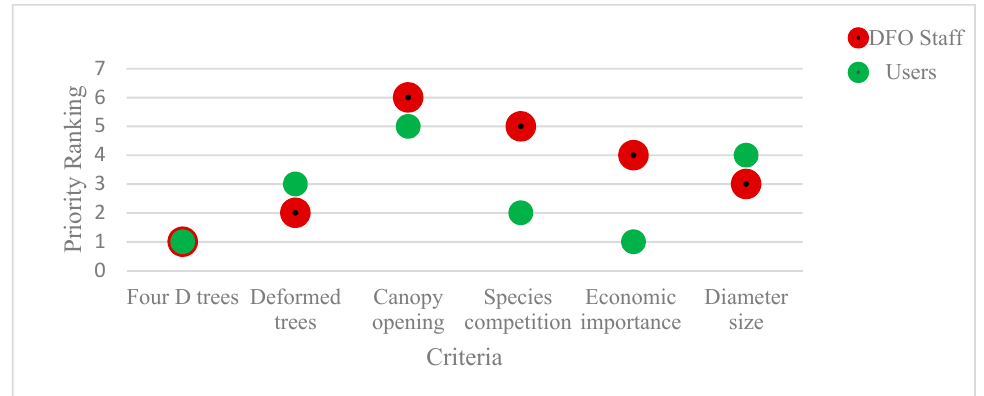
Figure 2. Priority ranking of DFO staff and users in selecting trees for harvesting. Source: Users and DFO officials of Kankali CFUG, Chitwan (2017).